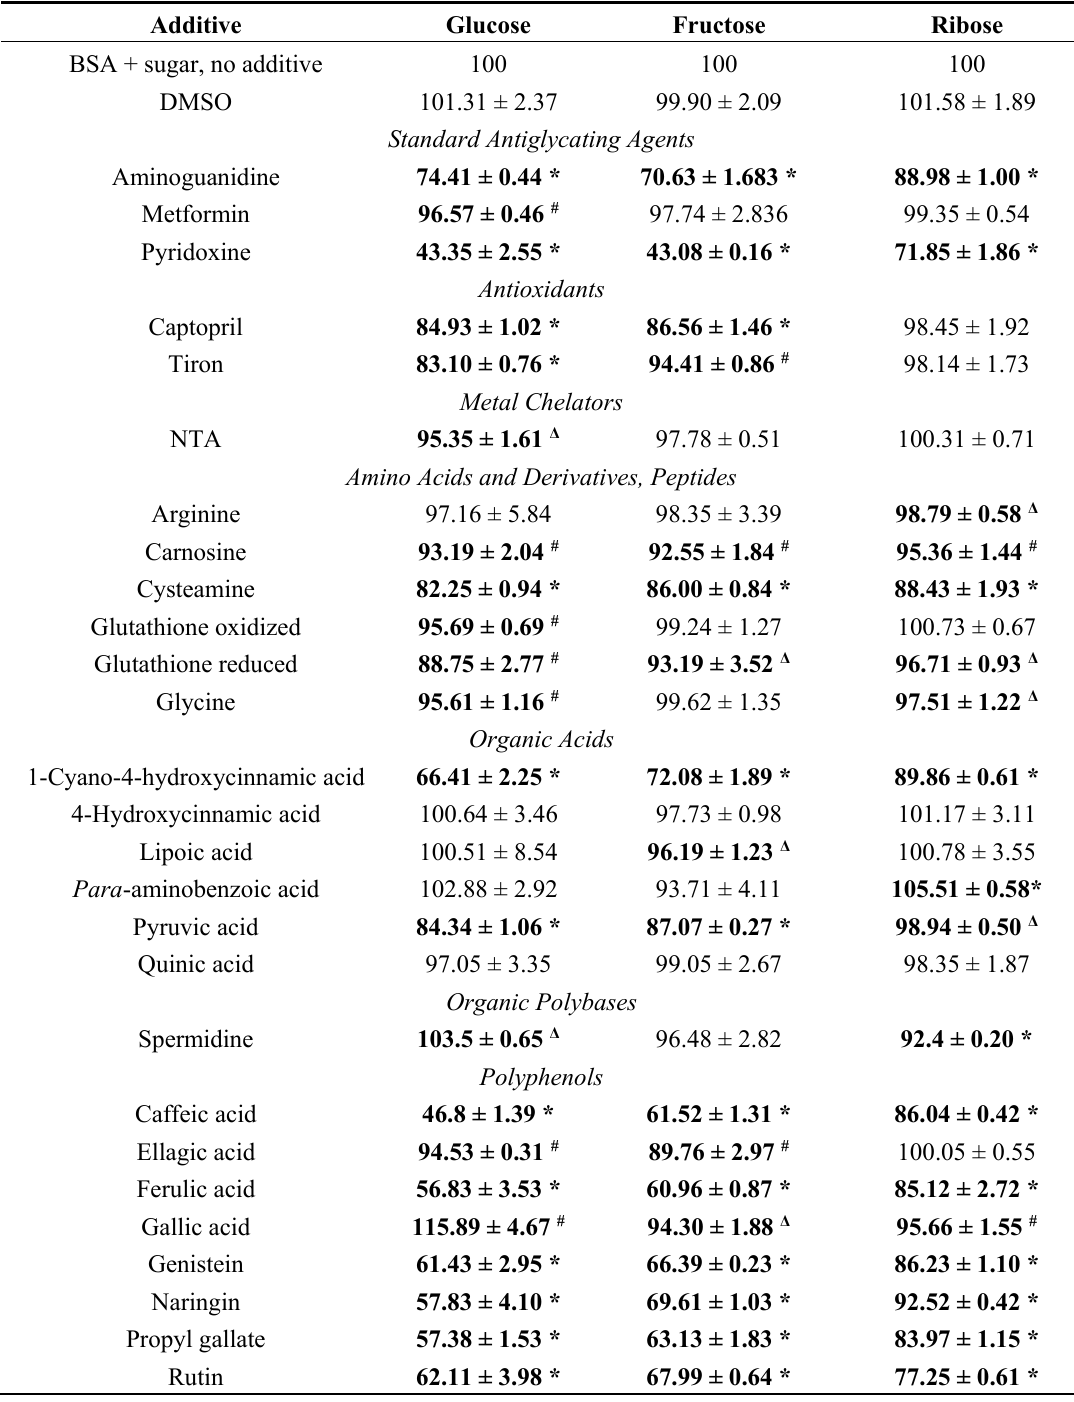
Table 4. The effect of various additives (1 mM) on the protein carbonyl content of glycated BSA induced by glucose, fructose and ribose (0.5 M), estimated with the protein carbonyl fluorometric assay. Δ p < 0.05, # p < 0.01, * p < 0.001 (paired Student’s t